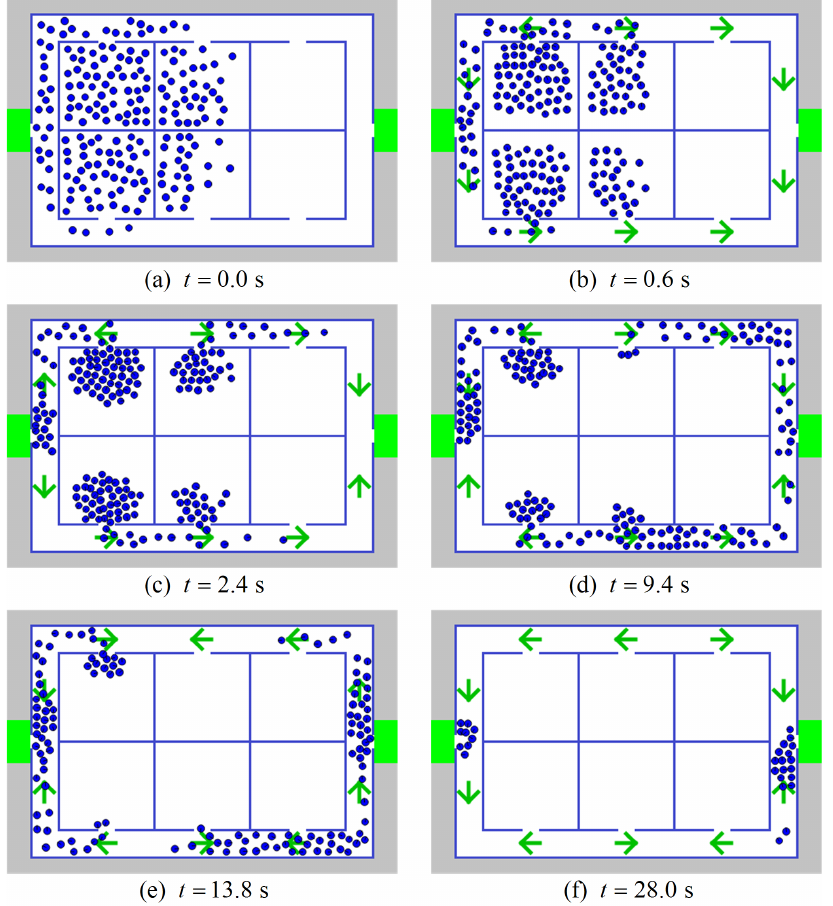
Figure 6. Six moments in a typical evacuation